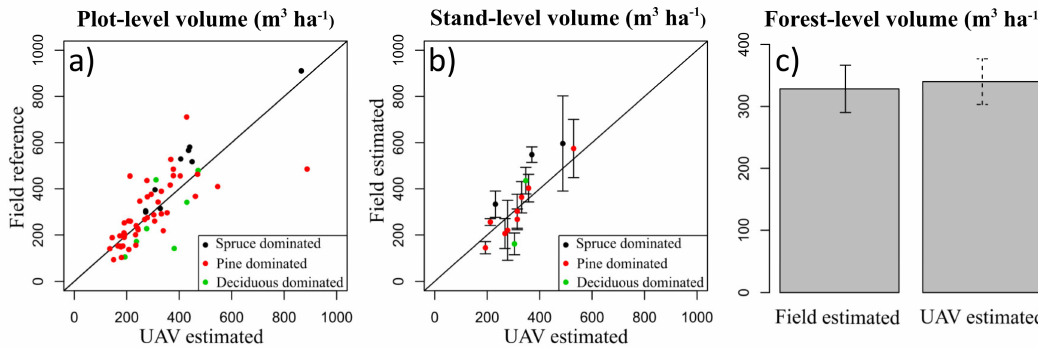
Figure 7. Summary of the validation at the plot ( a ), stand ( b ), and forest levels ( c ). Other than for the forest-level validation, the remaining scatterplots represent the UAV estimated against the field reference volume. The error bars represent two SE of the field measurements (full) or the non-parametric bootstrap (dashed). Table 3. Summary of the validation at the plot-, stand-, and forest-level volume estimates (m 3 ha − 1 ) in terms of RMSD and MD . For comparison, information about the variability ( SD ) and uncertainty ( SE ) of the field data was included.